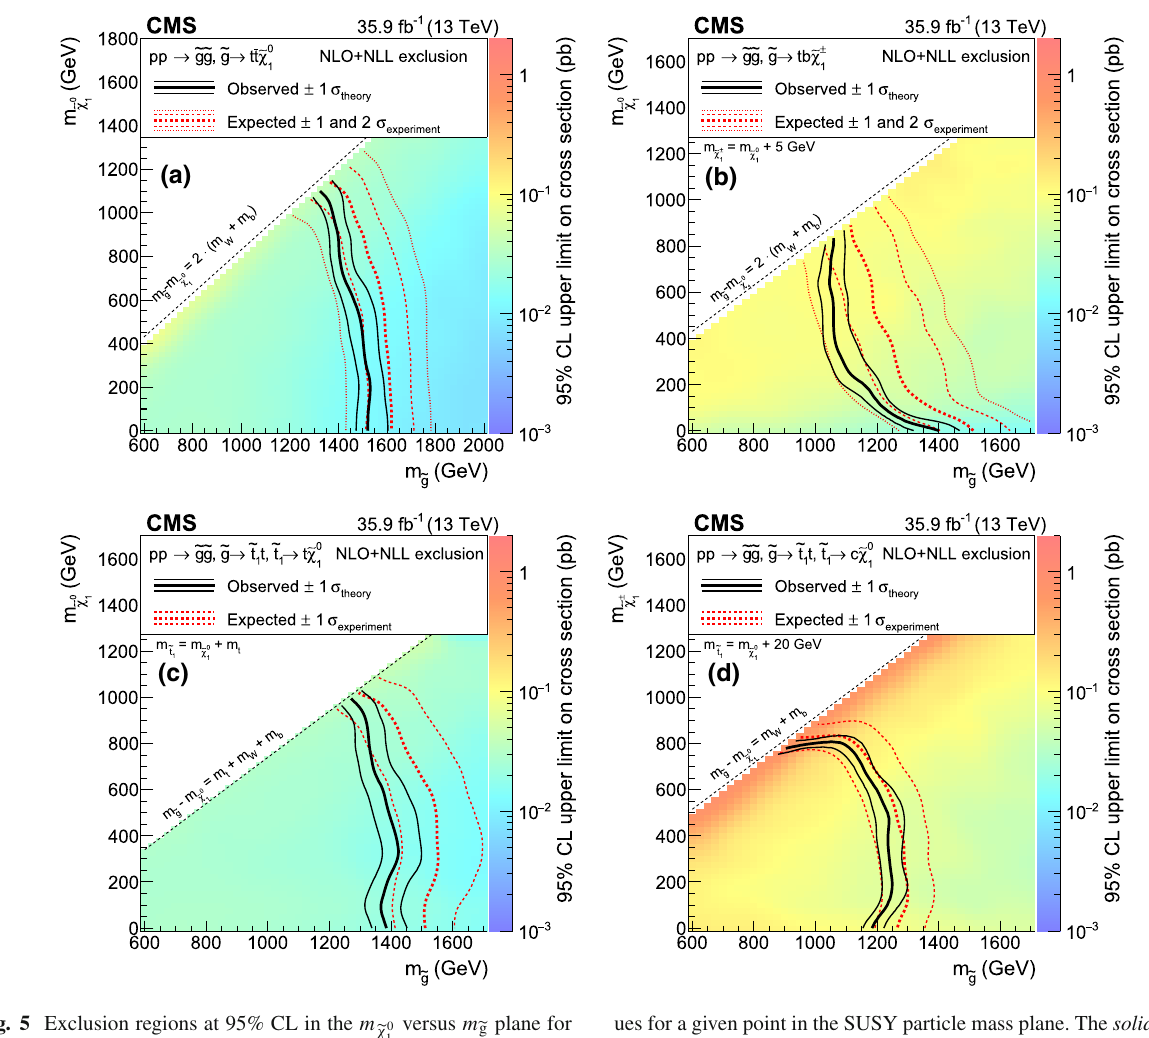
Fig. 5 Exclusion regions at 95% CL in the m (cid:2) χ 0 versus m (cid:2) g plane for ues for a given point in the SUSY particle mass plane. The solid , black 1 curves representtheobservedexclusionlimitsassumingtheNLO+NLL theT1tttt ( a )andT5ttbbWW ( b )models,withoff-shellthird-generation cross sections [46–51] ( thick line ), or their variations of ± 1 standard squarks, and the T5tttt ( c ) and T5ttcc ( d ) models, with on-shell third- = m + 5GeV, deviation ( thin lines ). The dashed , red curves show the expected lim- generation squarks. For the T5ttbbWW model, m (cid:2) χ ± (cid:2) χ 0 1 1 its with the corresponding ± 1 and ± 2 standard deviation = m for the T5tttt model, m (cid:2) t − m (cid:2) χ 0 t , and for the T5ttcc model, 1 = 20GeV and the decay proceeds through (cid:2) t → c (cid:2) χ 0 m (cid:2) t − m (cid:2) χ 0 . The 1 1 right-hand side color scale indicates the excluded cross section val-